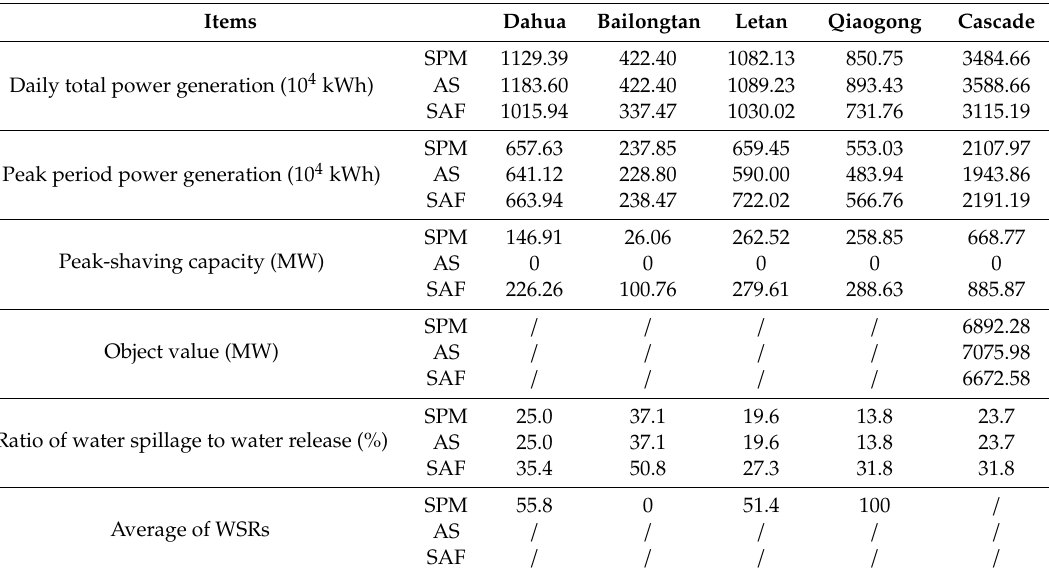
Table 4. Comparison results of the cascaded system on SPM, AS, and